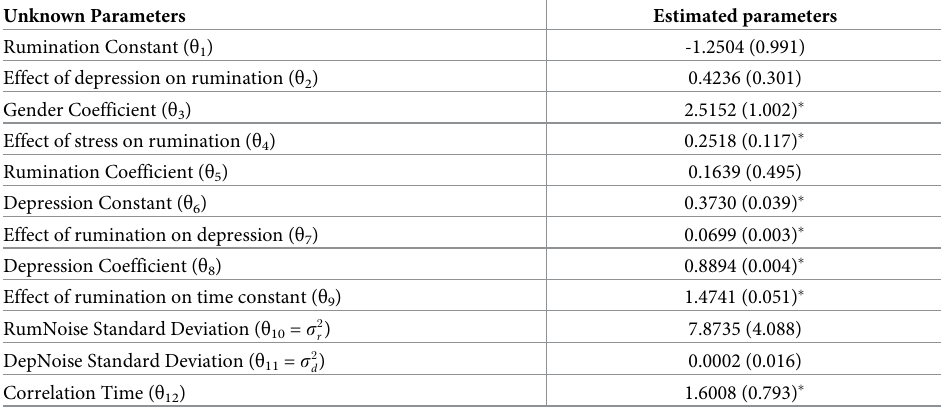
Table 1. Estimated parameters using indirect inference.